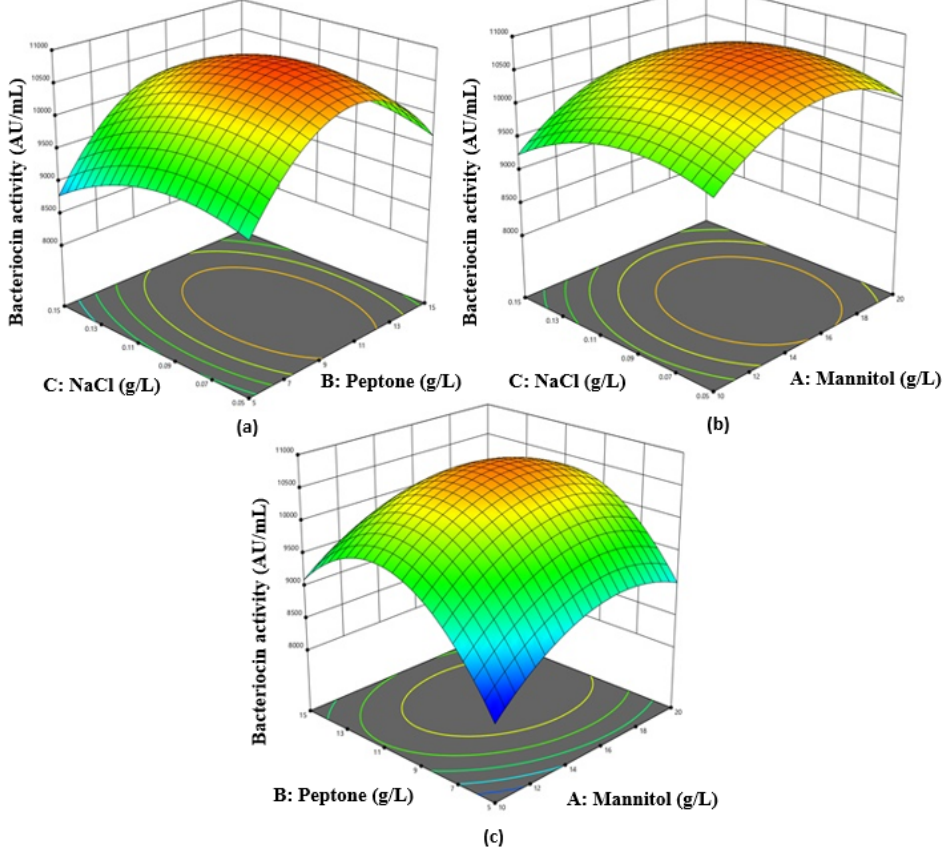
Figure 2. Response surface method plots (3D) displaying the distinct and combined impacts of the variables on the bacteriocin activity (AU/mL). ( a ) The interaction effect between NaCl and peptone concentrations (gL −1 ) on actual bacteriocin activity (AU/mL); ( b ) the interaction effect between NaCl and mannitol concentrations (gL −1 ) on actual bacteriocin activity (AU/mL); ( c ) the interaction effect between peptone and mannitol concentrations (gL −1 ) on actual bacteriocin activity (AU/mL).